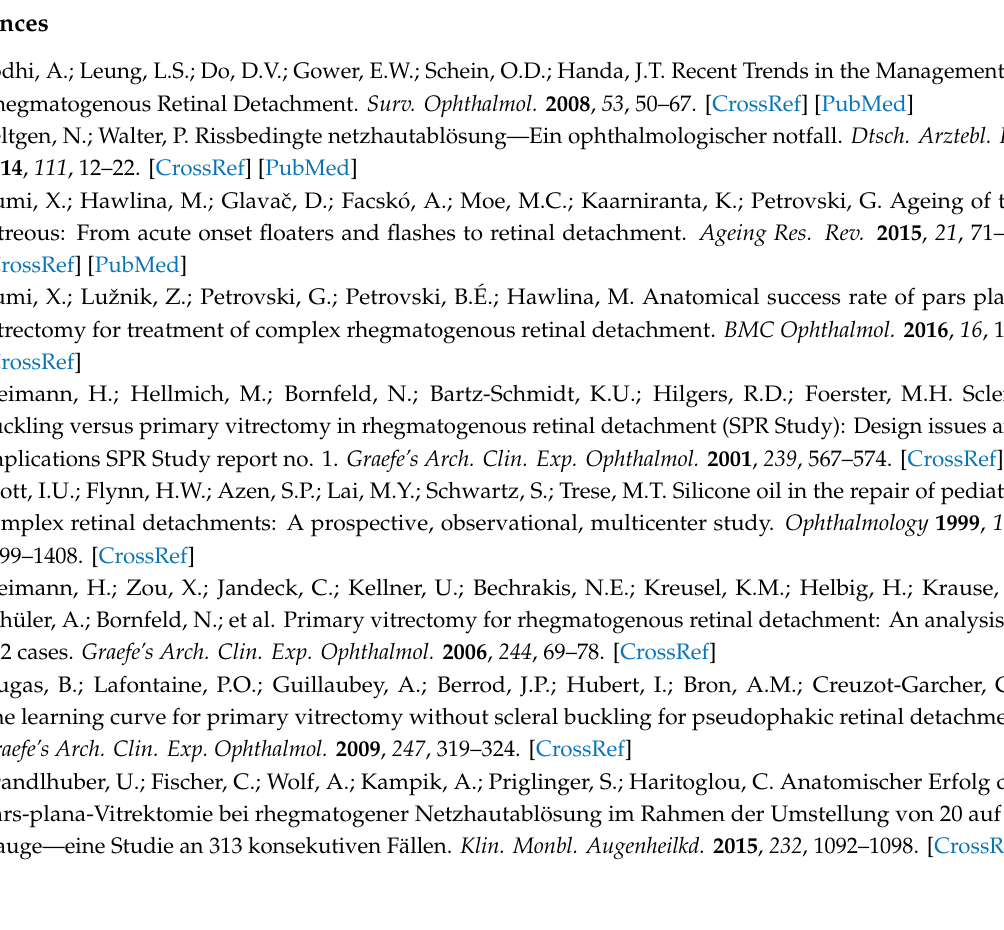
Figure S1: (A) Fit of the final model (BCVA measured in logMAR units). (B) Fit of the final model (BCVA measured in Snellen units); Figure S2: Predicted BCVA values measured in logMAR units for a level 0 and level 1 on each dichotomous covariate where other covariates in the model are fixed to the median (in case of continuous covariates) or mode (in case of dichotomous covariates); Figure S3: Predicted BCVA values measured in logMAR units for a range of values on each continuous covariate where other covariates in the model are fixed to the median (in case of continuous covariates) or mode (in case of dichotomous